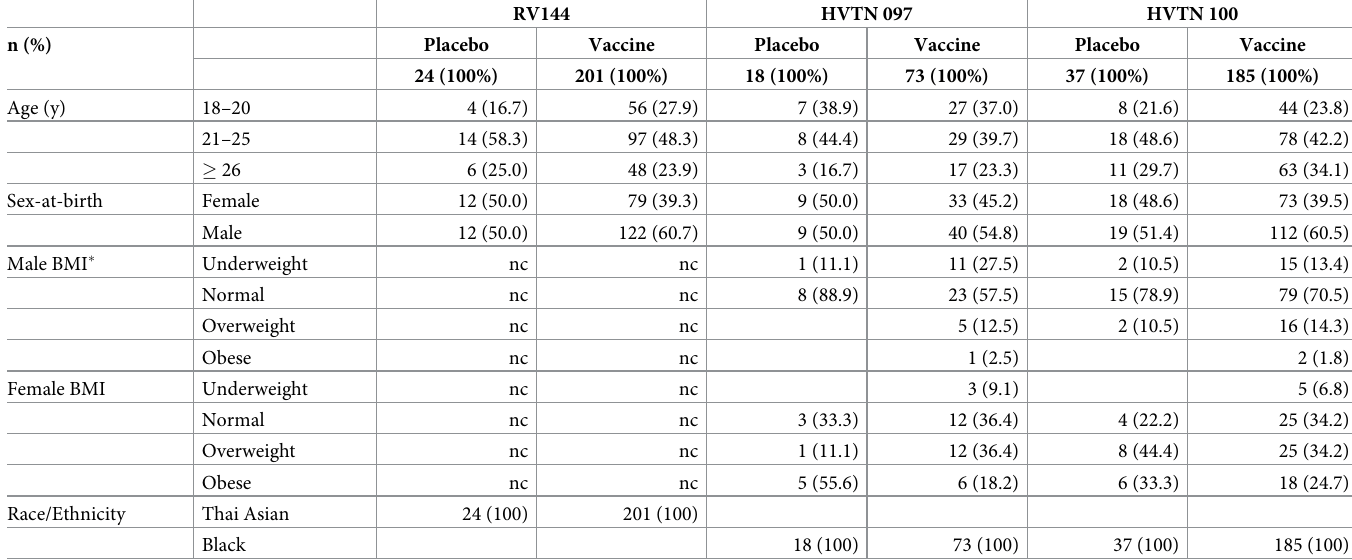
Table 1. Demographic information by treatment assignment (placebo vs vaccine) for RV144, HVTN 097, and HVTN 100 per-protocol